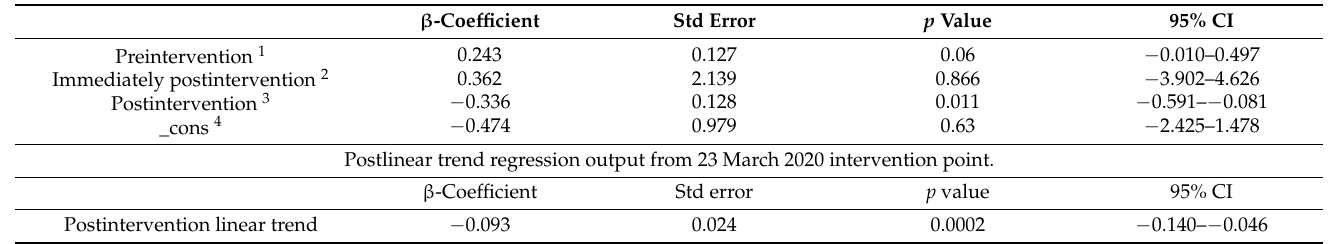
Table 3. Interrupted time series ordinary least-squares regression output at 23 March 2020